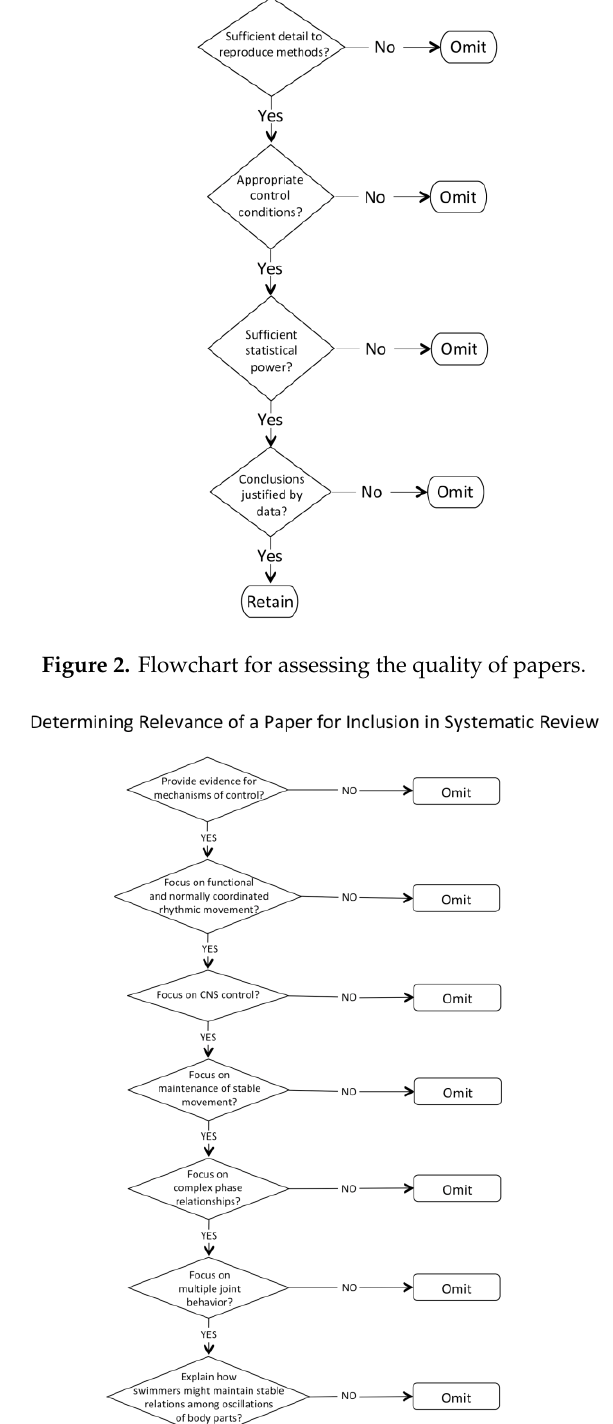
Figure 1. Frequency of publications matching the keywords “phase AND rhythm and coordination” in SCOPUS and Web of Science databases from 1979 to 2019.